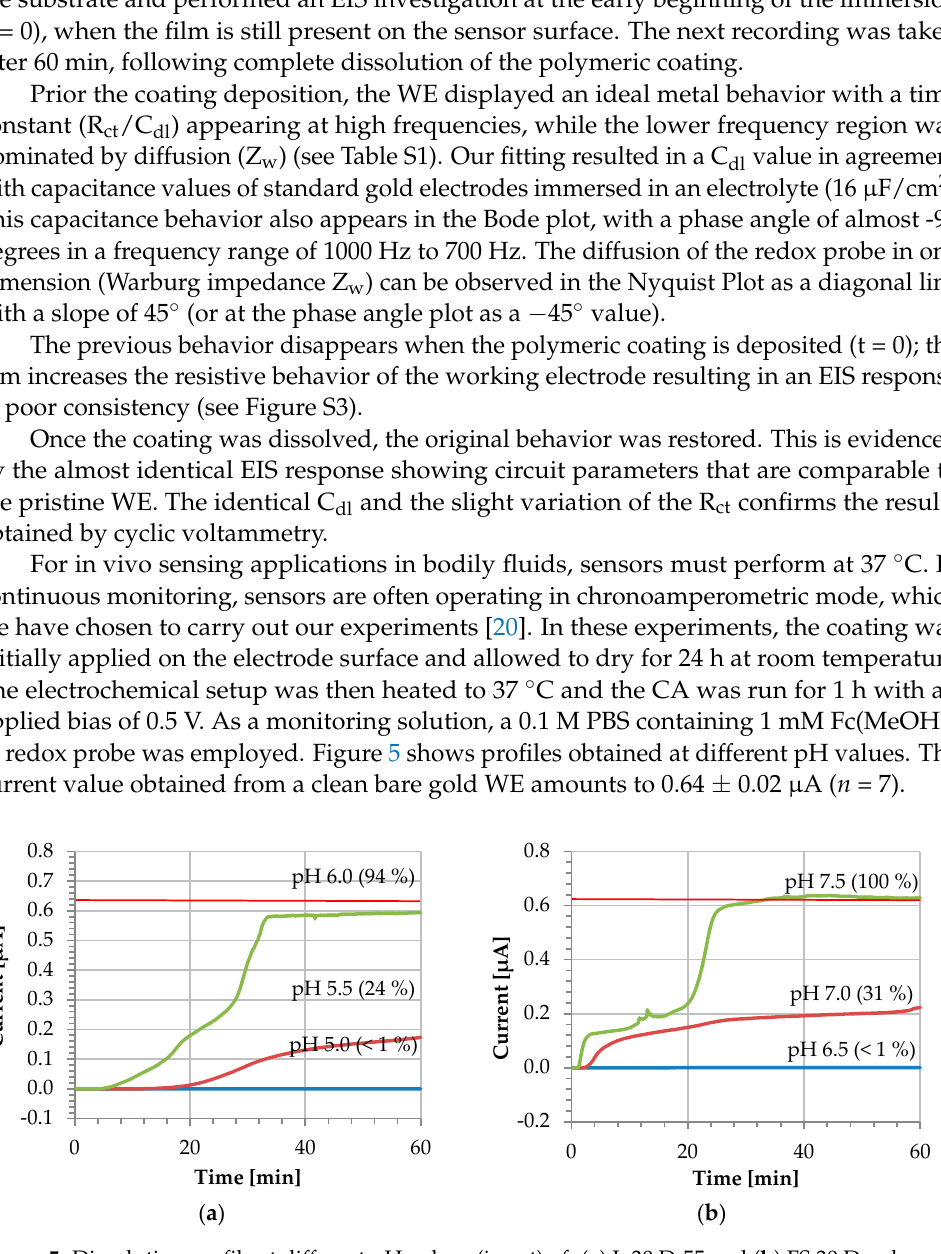
Figure 5. Dissolution profile at different pH values (i vs. t) of: ( a ) L 30 D-55 and ( b ) FS 30 D polymers. The red horizontal line indicates the current value of a bare gold electrode 0.64 ± 0.02 µA ( n = 7).